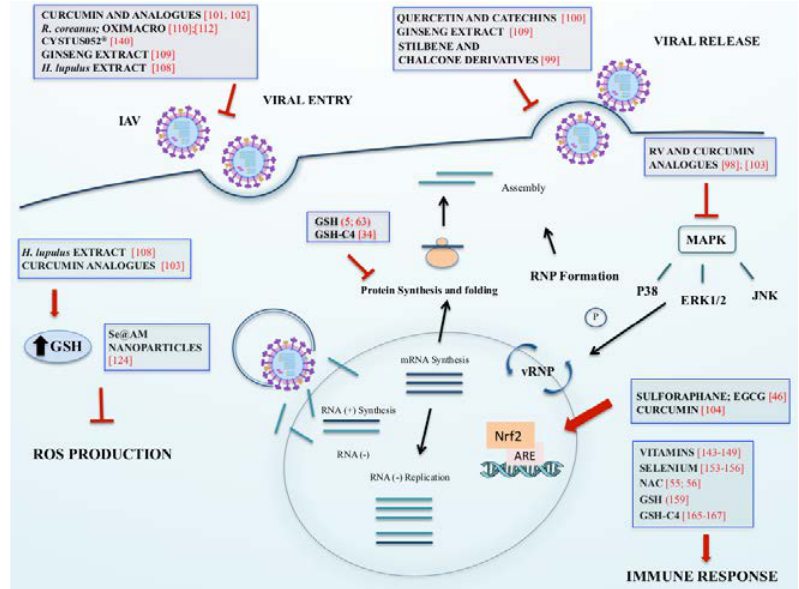
Figure 1. The picture represents the effects exerted by different compounds on influenza virus 530 infection and host response discussed above. 531 and host response discussed